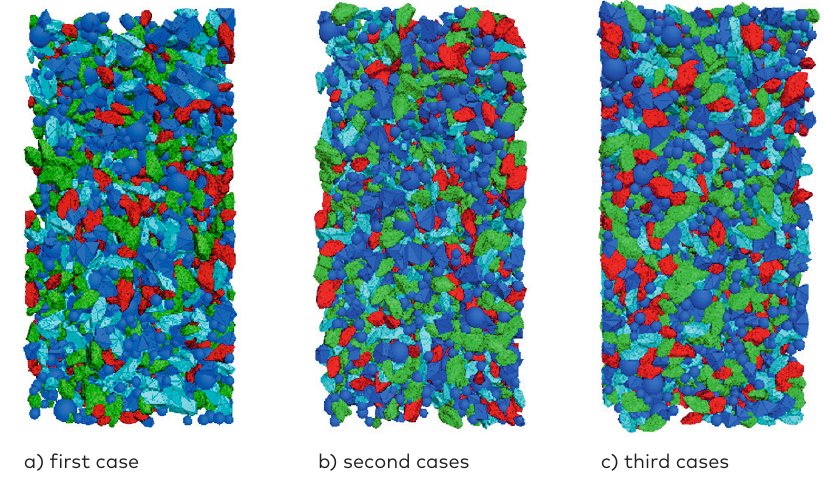
Figure 10. Models of three aggregate positions